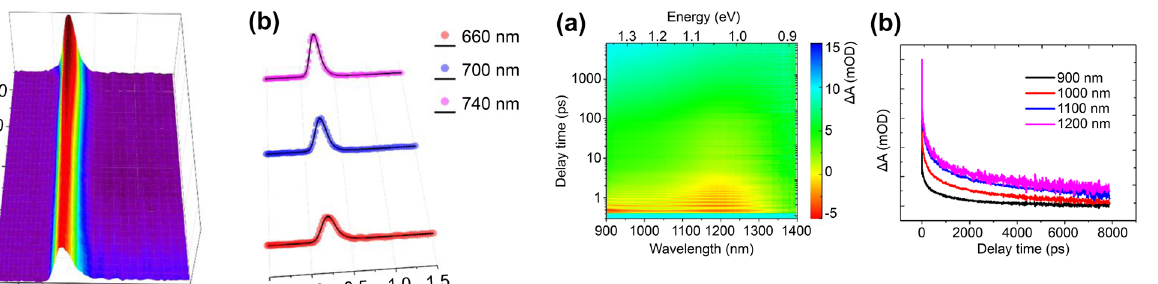
Figure 5: Infrared SP dynamics. (a) TA spectrum versus the delay time and probe wavelength at the infrared band. (b) Selective dynamics at 900 – 1200